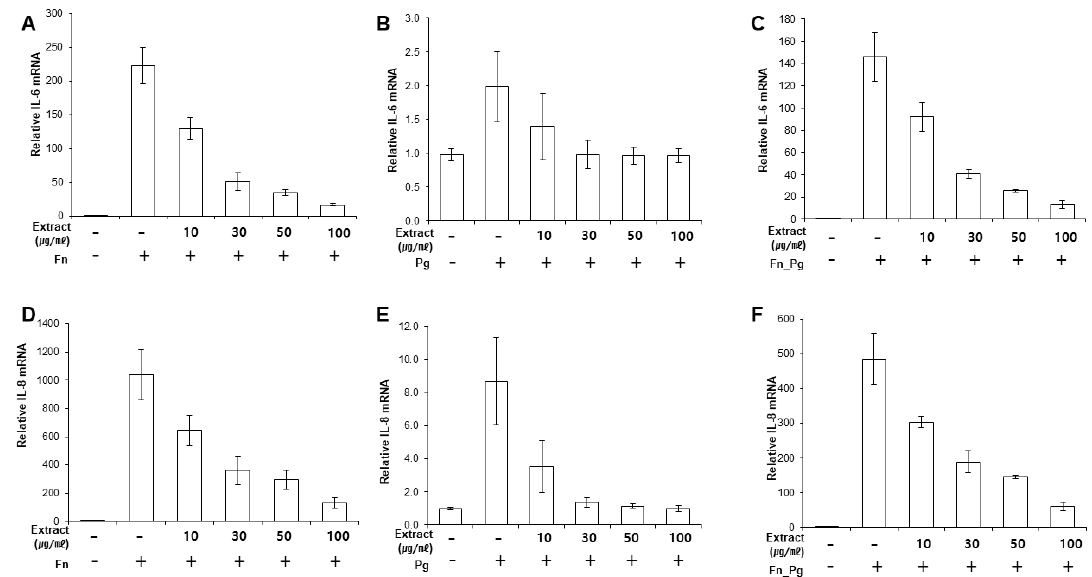
Figure 2. Dose-dependent inhibitory effects of OJE on pro-inflammatory cytokine expression in PDLFs infected with oral bacteria. ( A – C ), IL-6 mRNA; ( D – F ), IL-8 mRNA. Human PDLFs were pre-treated with 100 µg/mL OJE prior to bacterial infection (M.O.I = 100). The PDLFs were infected with F. nucleatum ( A , D ), P. gingivalis ( B , E ), or a mixture of F. nucleatum and P. gingivalis ( C , F ). The values are the mean ± standard deviation of triplicate assays. F. nucleatum : Fn; P. gingivalis : Pg; F. nucleatum and P. gingivalis : Fn_Pg.